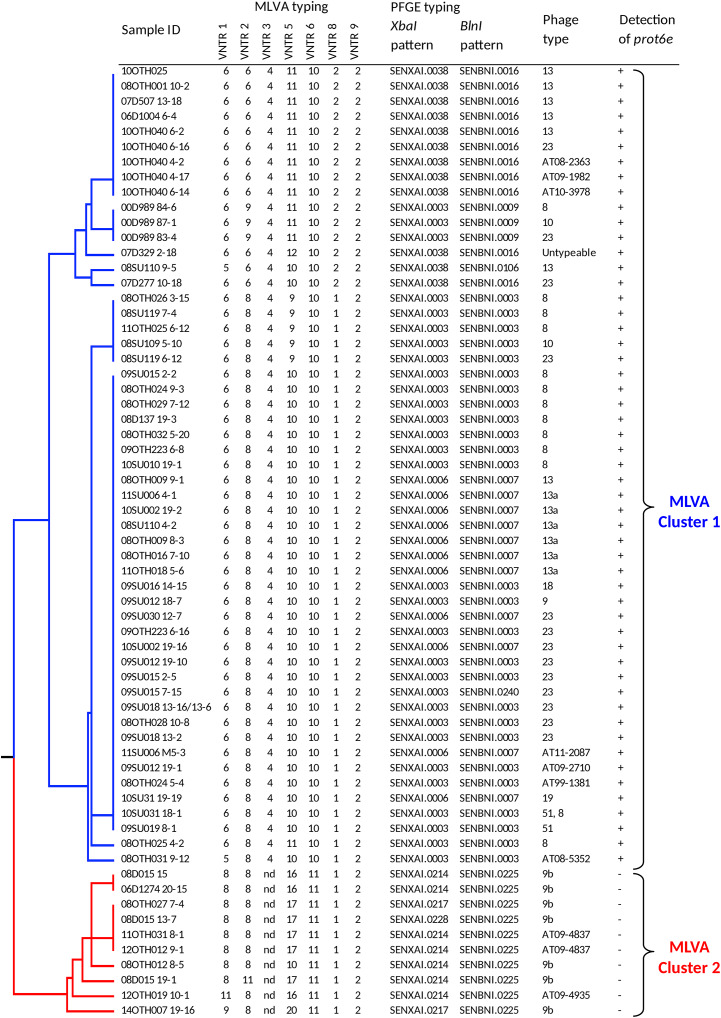
Dendrogram representing genetic relationships among 63 S. Enteritidis based on MLVA profiles. The table to the right of the dendrogram shows isolate IDs, the allelic pattern for each MLVA profile, PFGE and phage types, and presence of the prot6e gene. Division of the samples into two very distinct MLVA clusters, 1 (blue) and 2 (red), is indicated to the right.